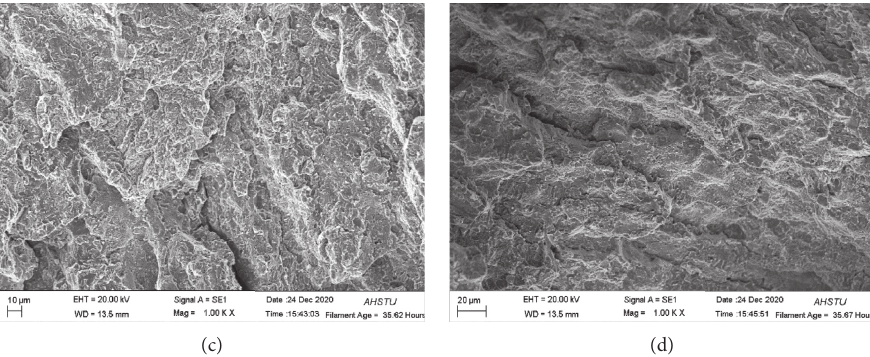
Figure 9: SEM micrographs showing tensile fracture morphologies: (a) overall fracture appearance; (b) primary fibre zone; (c) radial zone; (d) secondary fibre